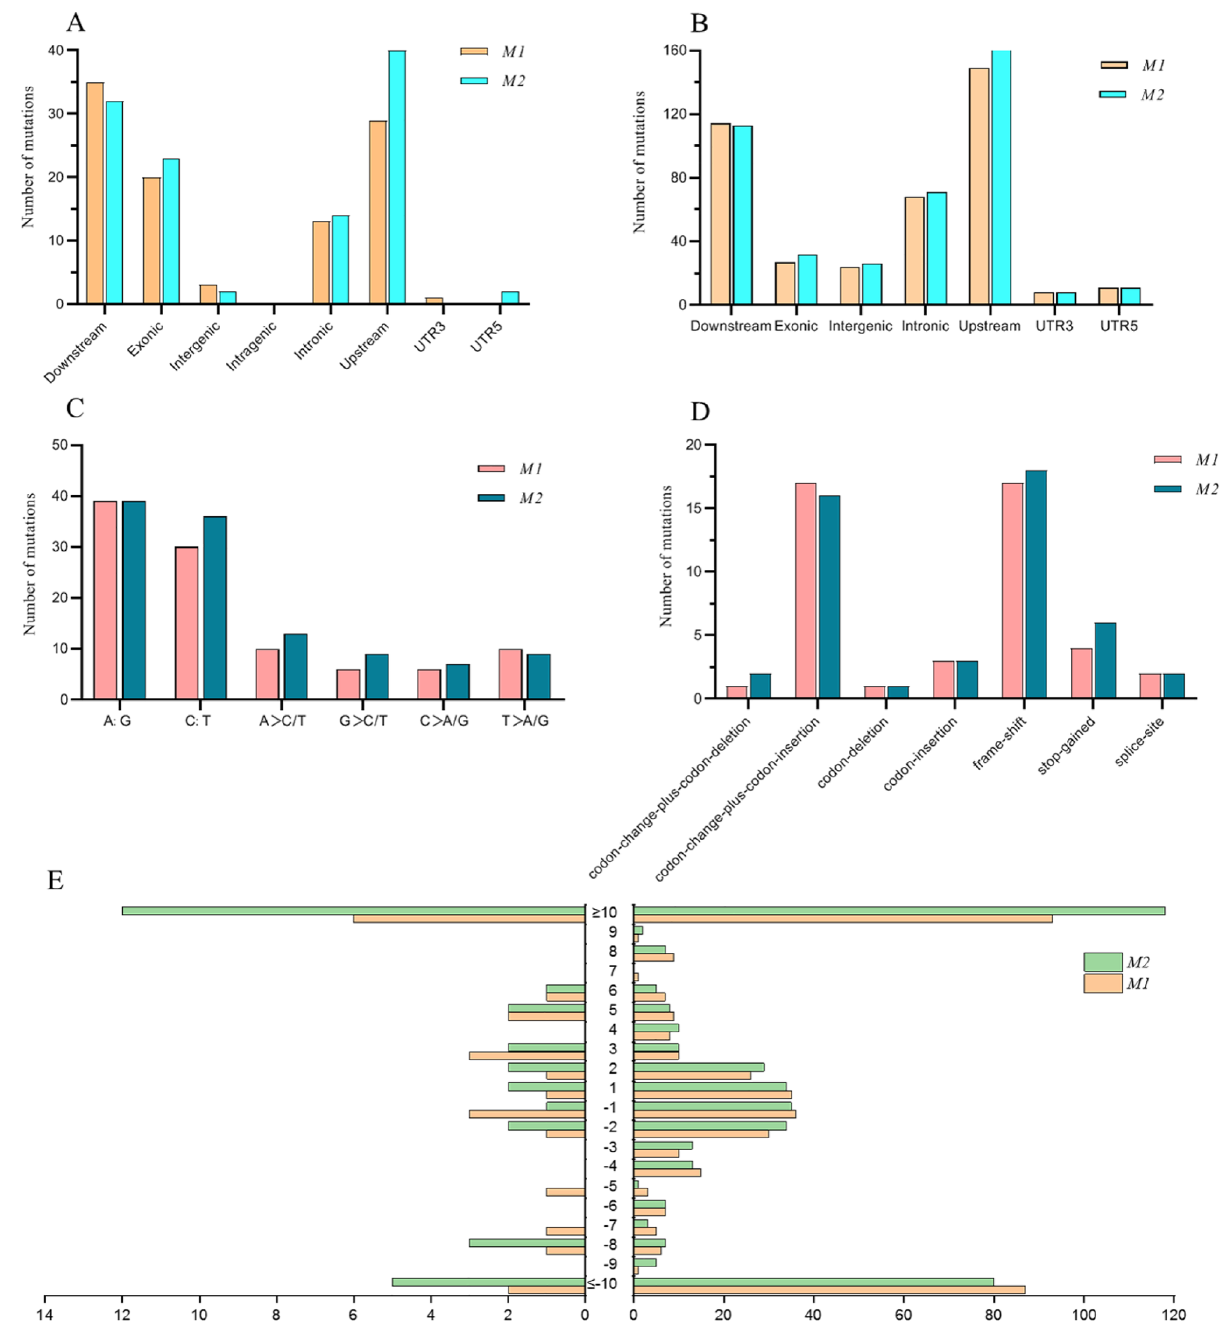
Figure 6. Mutations produced by DC electrophoresis bath mutagenesis. ( A ) SNPs variant types in the genome; ( B ) InDels variant types in the genome. ( C ) Mutation of different categories of SNPs induced by DC bath; ( D ) InDels variants in the genetic region; and ( E ) InDels length distribution in CDS and